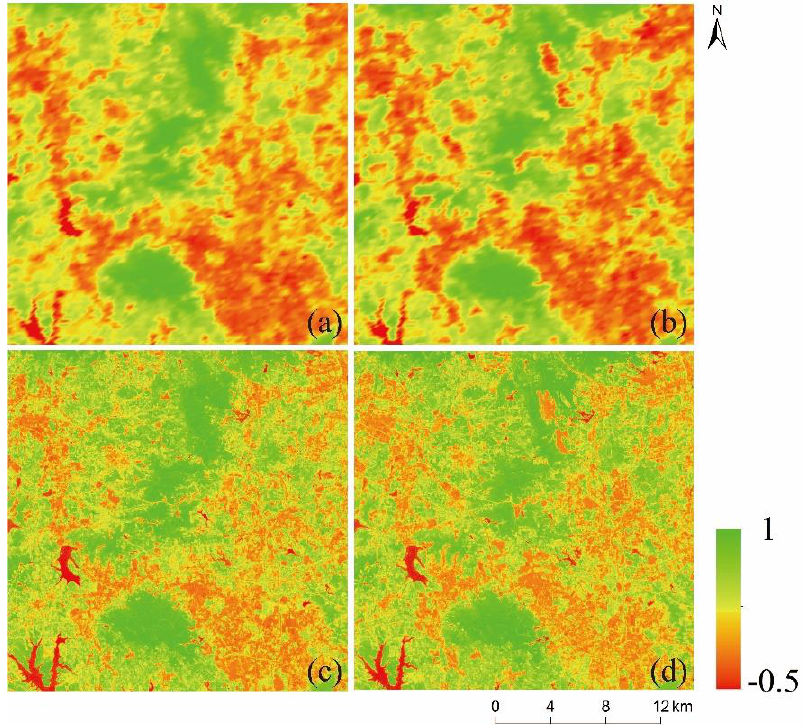
Figure 5. Testing datasets of urban areas. ( a , b ). MODIS_NDVI on 1 November 2000 and 7 November 2002; ( c , d ). Landsat_NDVI on 1 November 2000 and 7 November 2002.